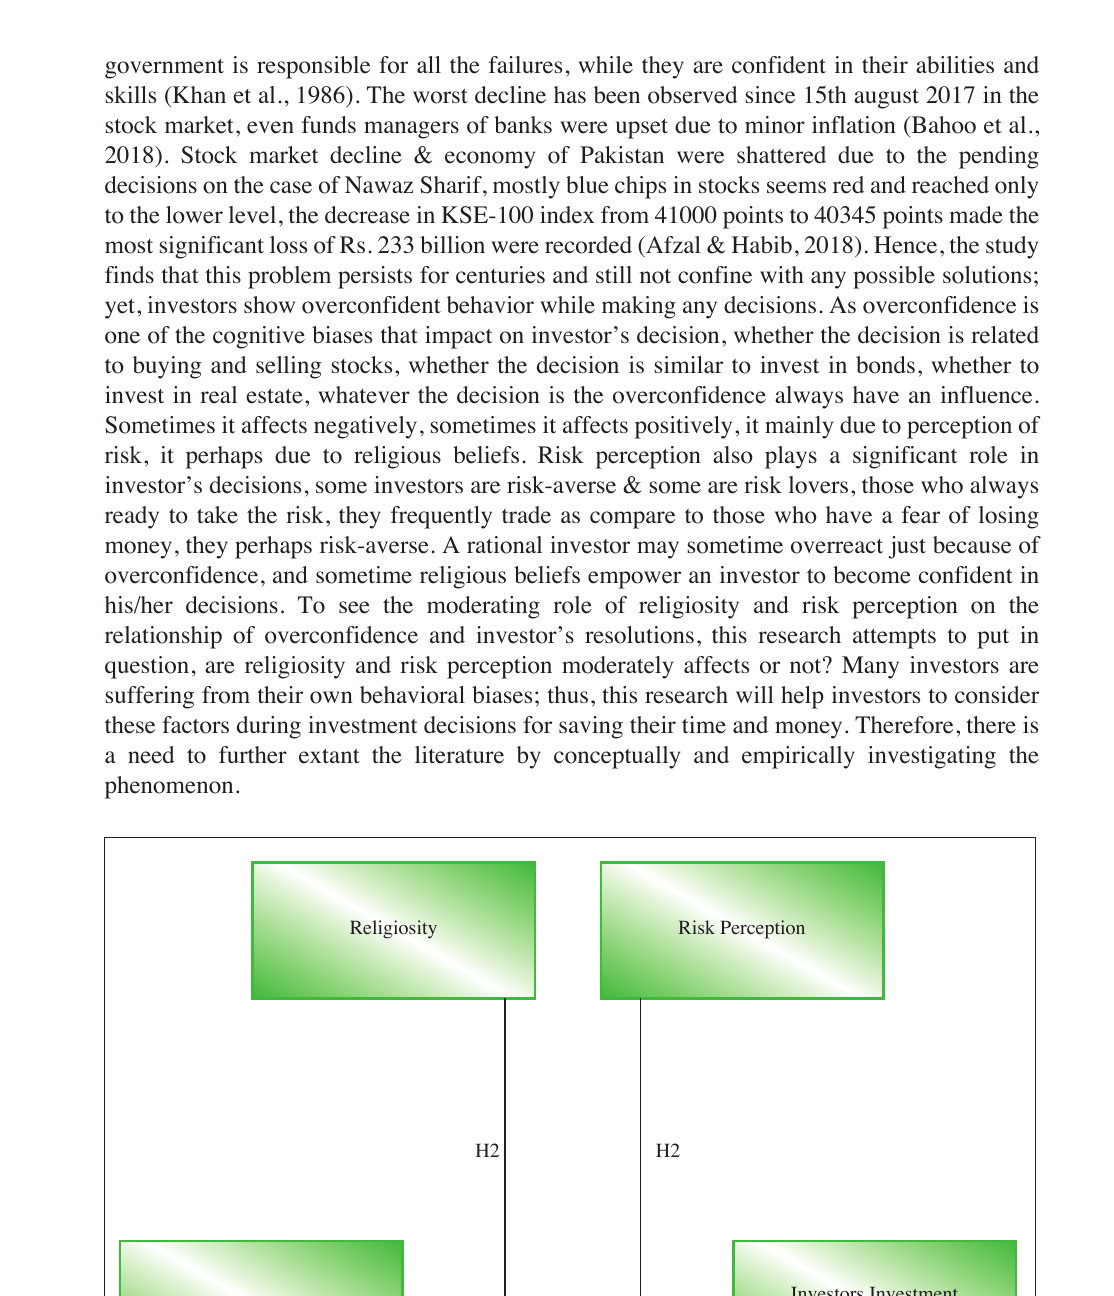
DecisionsOverconfidence Figure 1: Conceptual Research Model